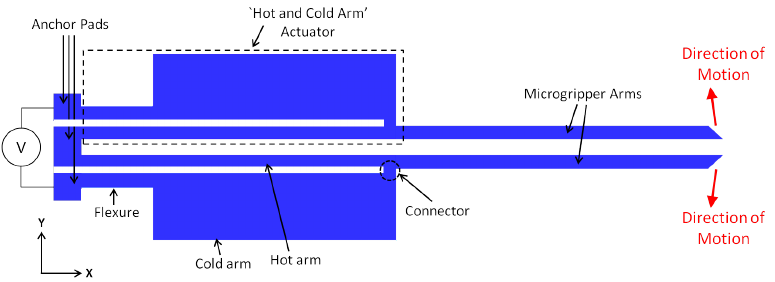
Figure 2. Schematic diagram of the microgripper design (not-to-scale) consisting of two ‘hot and cold arm’ actuators that are placed anti-symmetrically next to each other and that are electrically connected in an in series